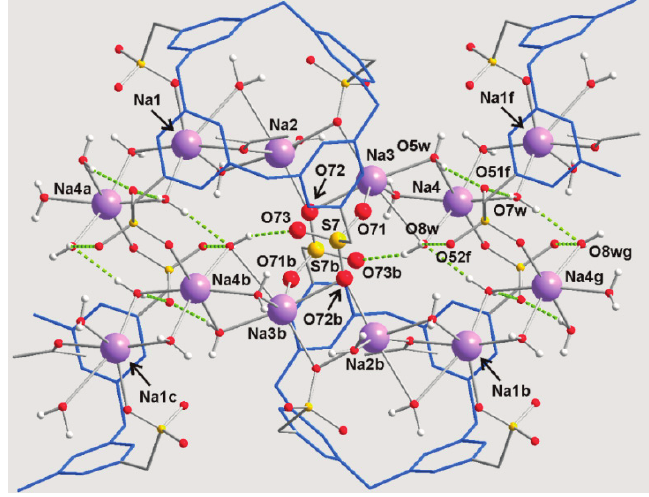
Figure 5. Perspective view of the double chain of sodium atoms for 2a . Resorcinarenyl cycles are showed in blue. Symmetry transformation: (a) x , y + 1, z ; (b) − x + 1, − y , − z + 1;